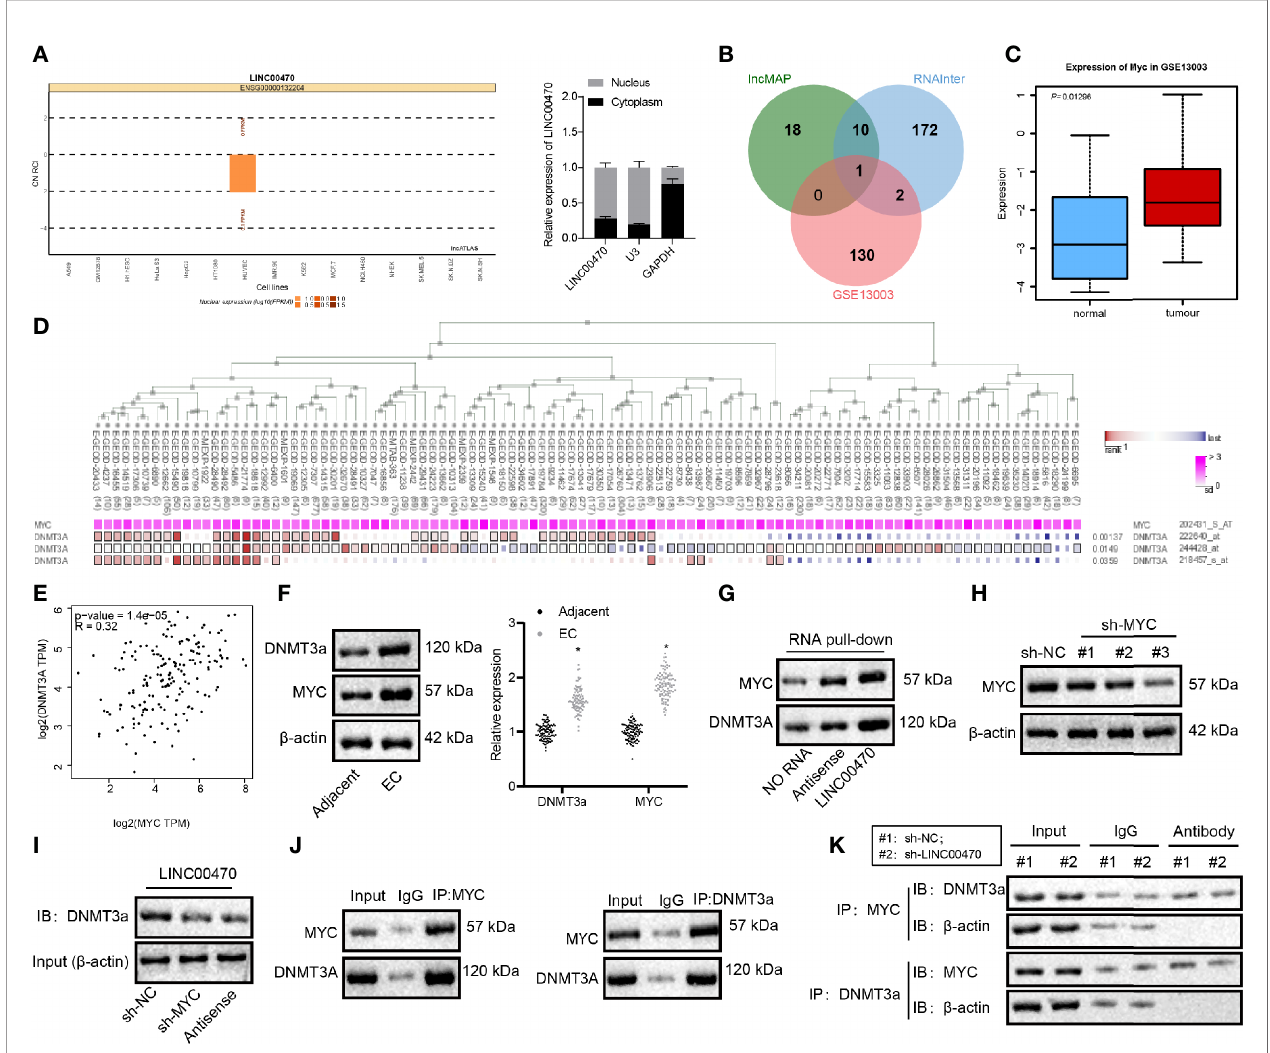
FIGURE 4 | LINC00470 bound to MYC protein in EC and strengthened the binding of MYC to DNMT3a. (A) The subcellular localization of LINC00470 predicted by LncATLAS and the expression distribution of LINC00470 in the cytoplasm and nucleus assessed by nucleus/cytoplasm separation and RT-qPCR. (B) Venn diagram displaying the intersection between transcription factors bound to LINC00470 predicted by LncMAP and RNAInter and the signi fi cantly upregulated genes obtained by GSE13003; the intersected gene was MYC. (C) The expression box plot of MYC in the dataset GSE13003. The red box indicates the expression in EC samples, and the blue box indicates the expression in normal samples. (D) The signi fi cant co-expression between MYC and DNMT3a acquired by MEM analysis. (E) The correlation between the expression of MYC and DNMT3a in EC obtained by GEPIA analysis. (F) The mRNA expression of MYC and DNMT3a in EC tissues and adjacent normal tissues (n = 103) determined with RT-qPCR (left panel); Representative images of Western blots of MYC and DNMT3a proteins in EC tissues and adjacent normal tissues (n = 103) normalized to b -actin (right panel). (G) The binding of LINC00470 to MYC and DNMT3a assessed by RNA pull-down assay. (H) Western blot analysis of the expression of MYC in KLE cells after sh-MYC-1, sh-MYC-2, or sh-MYC-3 treatment normalized to b -actin, and sh-MYC-3 with the highest silencing ef fi ciency were selected for subsequent experiments. (I) Changes in the binding of sense-LINC00470 to DNMT3a detected by RNA pull-down assay. (J) The binding of MYC and DNMT3a assessed by Co-IP. (K) The binding of MYC to DNMT3a in KLE cells after sh-LINC00470 treatment examined by Co-IP. Cellular experiment was independently repeated 3